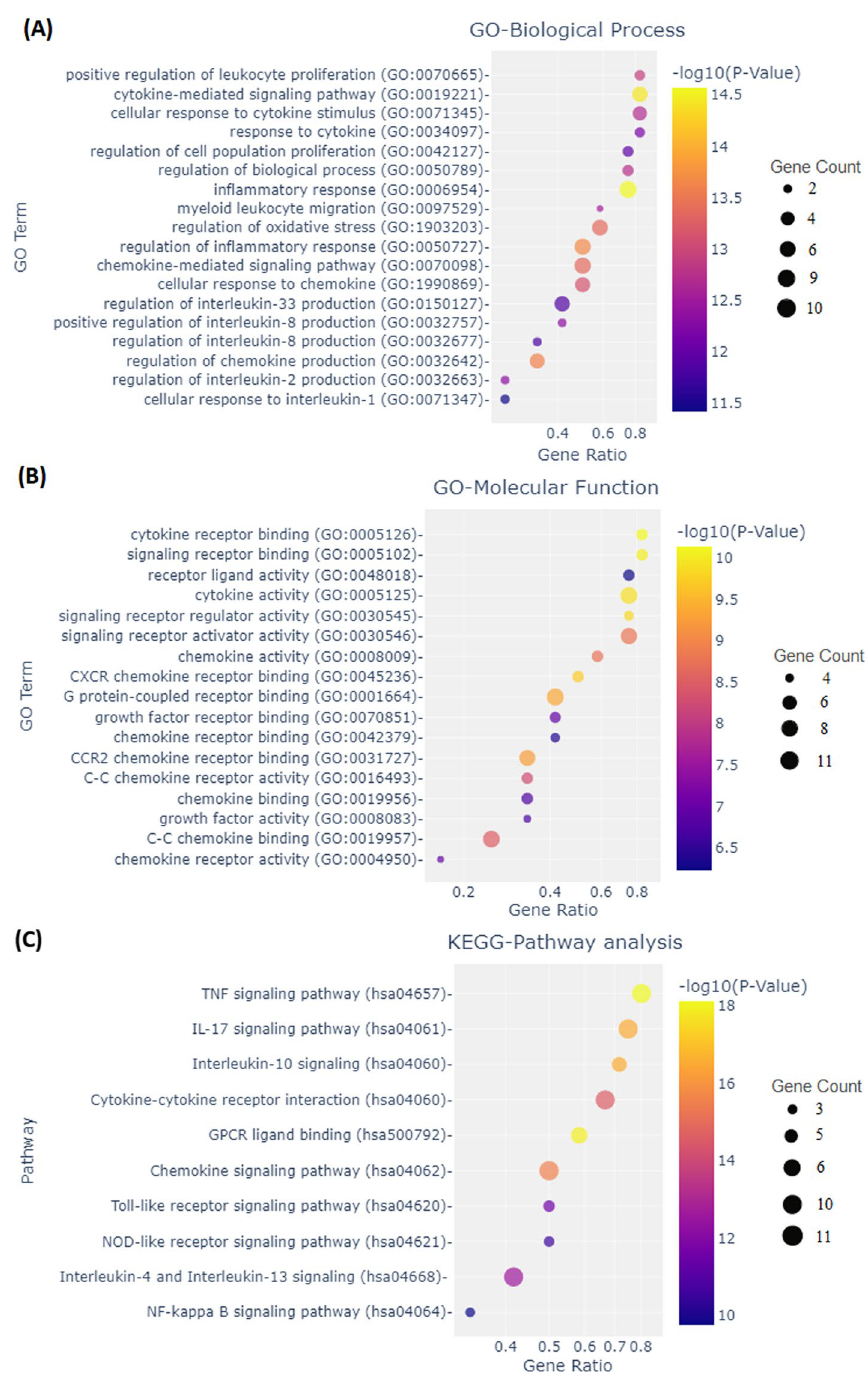
Fig. 7 GO enrichment and KEGG pathway analysis for major putative targets. A Biological process; B Molecular function; and C Top 10 KEGG pathway. KEGG, Kyoto Encyclopedia of Genes and